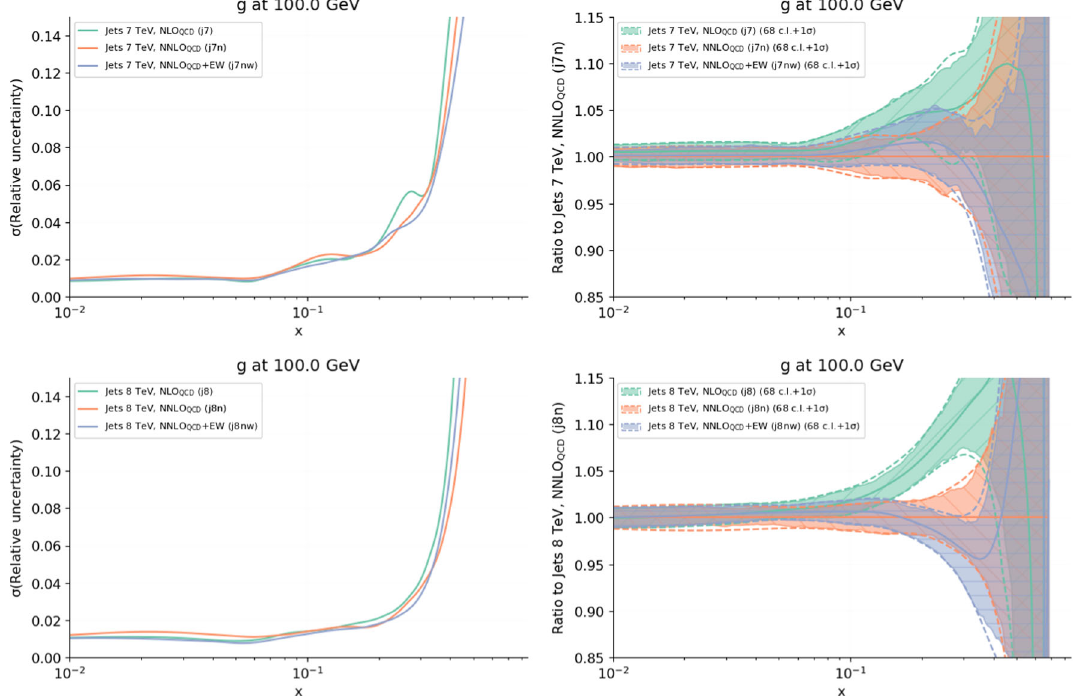
Fig. 8 Same as Fig. 7, but now comparing fits with NLO, NNLO and NNLO+EW theory for 7 TeV (top: fits #j7, #j7n, #j7nw respectively) and 8 TeV (bottom: fits #j8, #j8n, #j8nw). All results are now shown as ratios to the NNLO fit